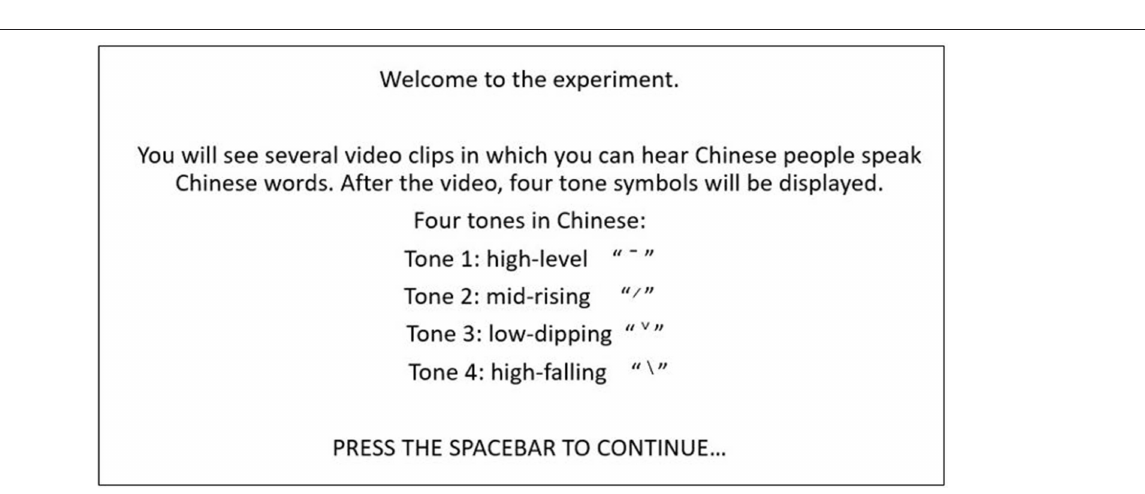
Frontiers in Communication |